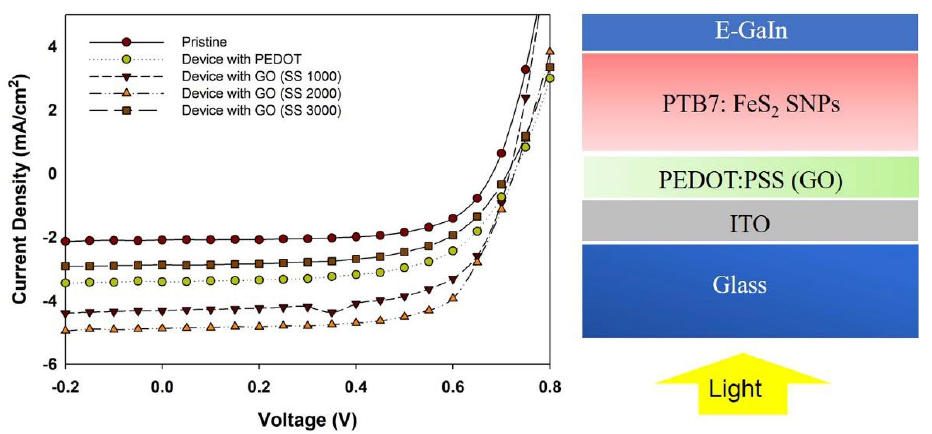
Figure 4. J–V curve of PBT7: FeS 2 SNPs solar cells without and with hole transport buffer layers such as PEDOT:PSS and GO. Table 1. Device’s parameters such as short circuit current density (J sc ), open circuit voltage (V oc ), fill 232 factor (FF), and power conversion efficiency (PCE) without the hole transport buffer layer and with 233 the hole transport buffer layer of PEDOT: PSS (or GO).